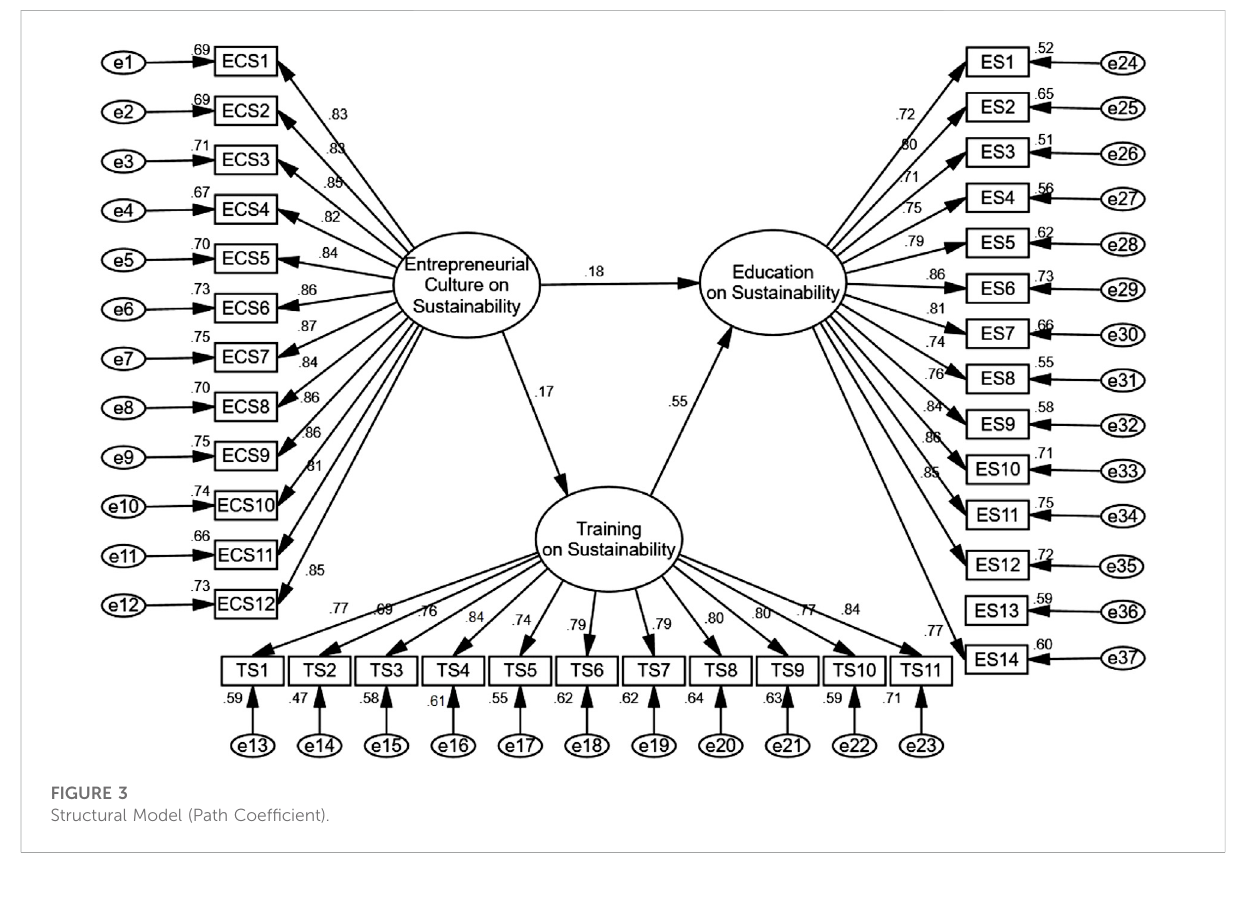
FIGURE 3 Structural Model (Path Coef fi cient).